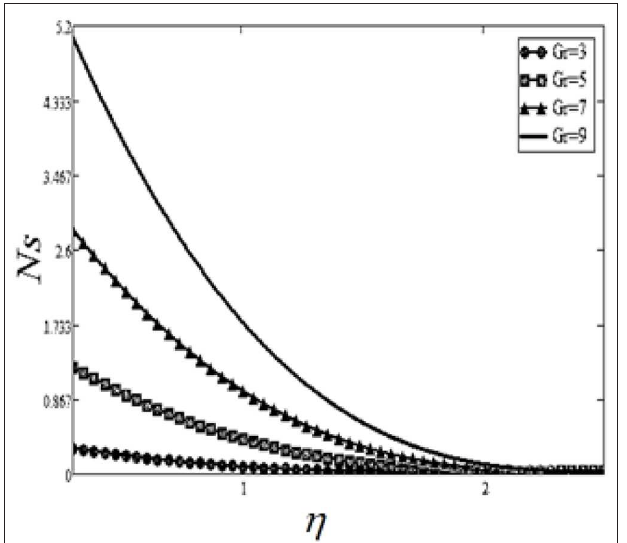
FIGURE 9 | Entropy generation plot for Br .